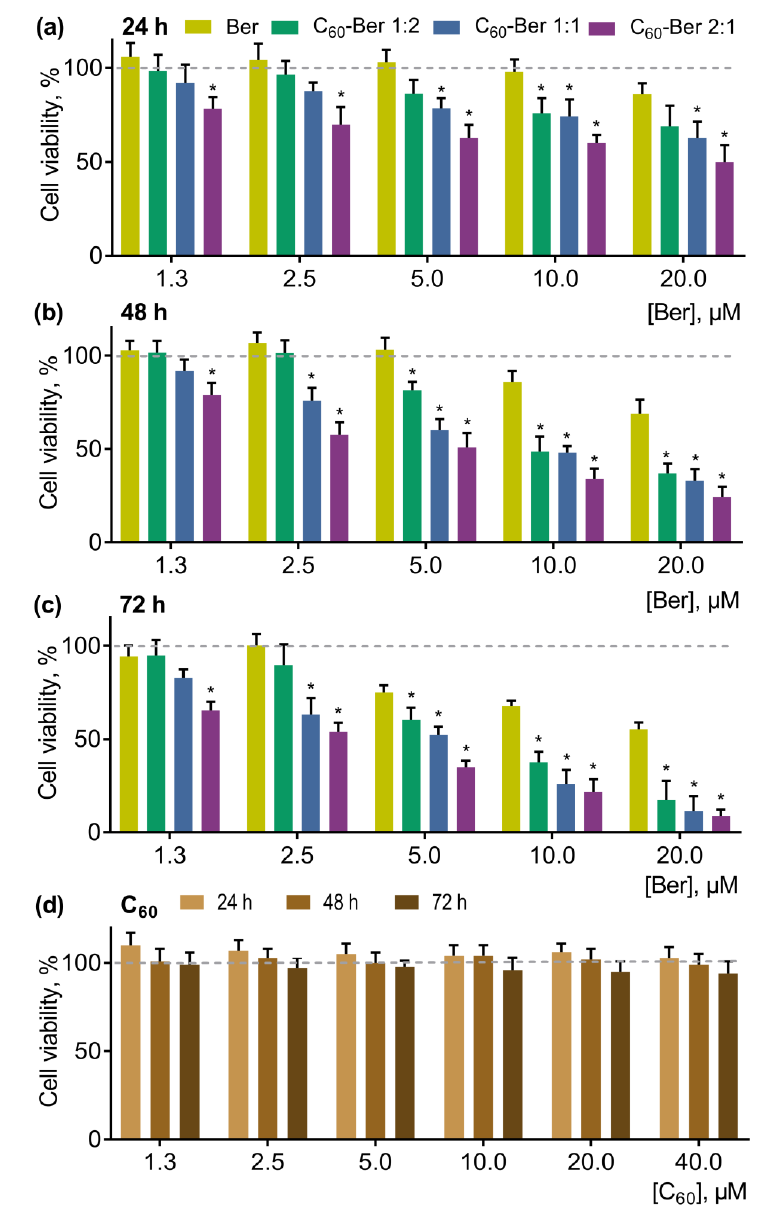
Figure 9. Viability of CCRF-CEM cells, treated with a free Ber or C 60 -Ber nanocomplexes in a Ber-equivalent concentrations for 24 ( a ), 48 ( b ), and 72 h ( c ) (* p ≤ 0.01 in comparison with the free Ber) as well as viability of CCRF-CEM cells, treated with a free C 60 in a nanocomplex-equivalent concentrations for 24, 48, and 72 h ( d ).